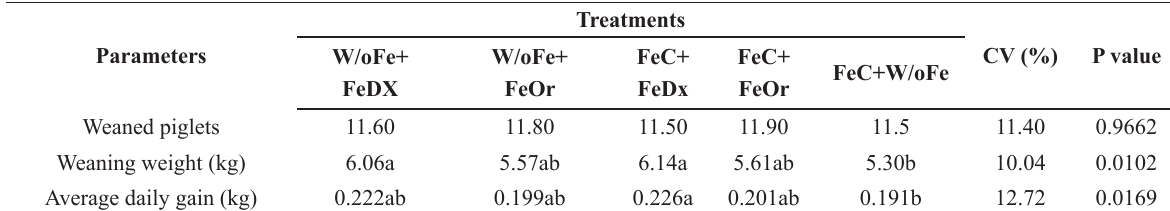
Performance of piglets as a function of iron chelate supplementation of sows and the type of iron supplementation at